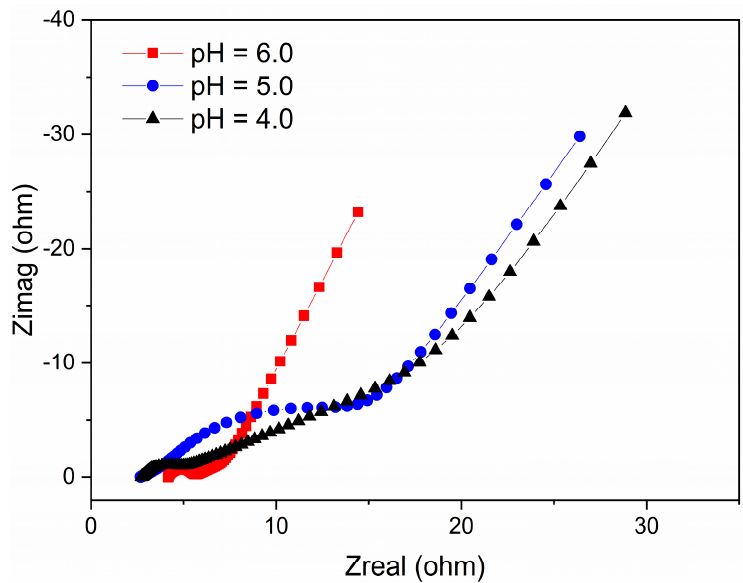
Figure 1. Output voltage ( A ), power density ( B ), polarization curves ( C ), and COD removal effi- ciency and CE ( D ) of single-chamber MFCs under different pH stresses.